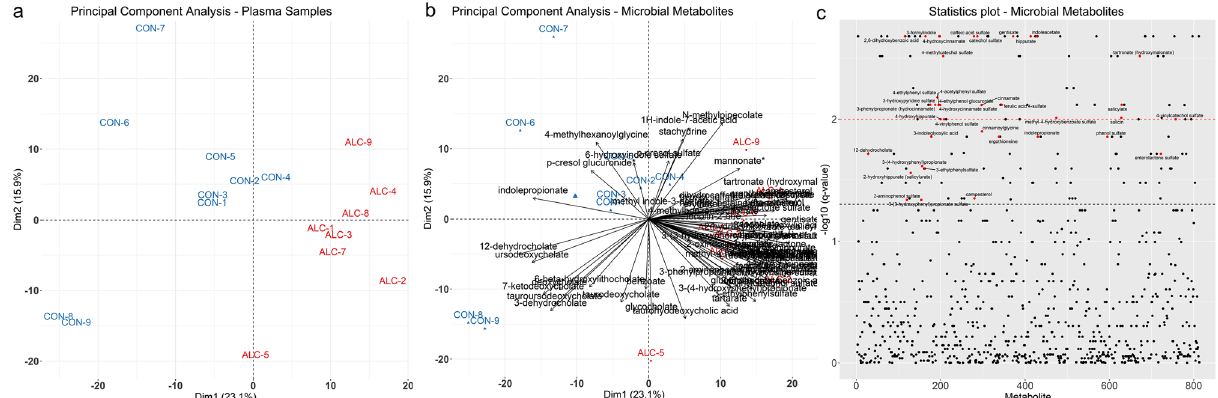
Figure 1. Plasma microbial-derived metabolites distinguish alcohol-exposed and control dams. ( a ) Dimension 1 and 2 of the PCA on the scaled metabolite profiles within plasma of nine control (CON) and eight alcohol- exposed (ALC) dams. ( b ) PCA biplot with microbial-derived metabolites overlaid onto the samples plot. PCA values for the MDPs are presented in Supplemental Table S2. ( c ) T-statistic plot of all 813 metabolites (arranged alphabetically along the x-axis) against their log10 q -values. The black dashed line indicates the cut-off for the FDR adjusted value of q < 0.05, and the red dashed line indicates q < 0.01. Red dots indicate microbial-derived metabolites having q < 0.05. Sample size is n = 9 control and n = 8 alcohol-exposed